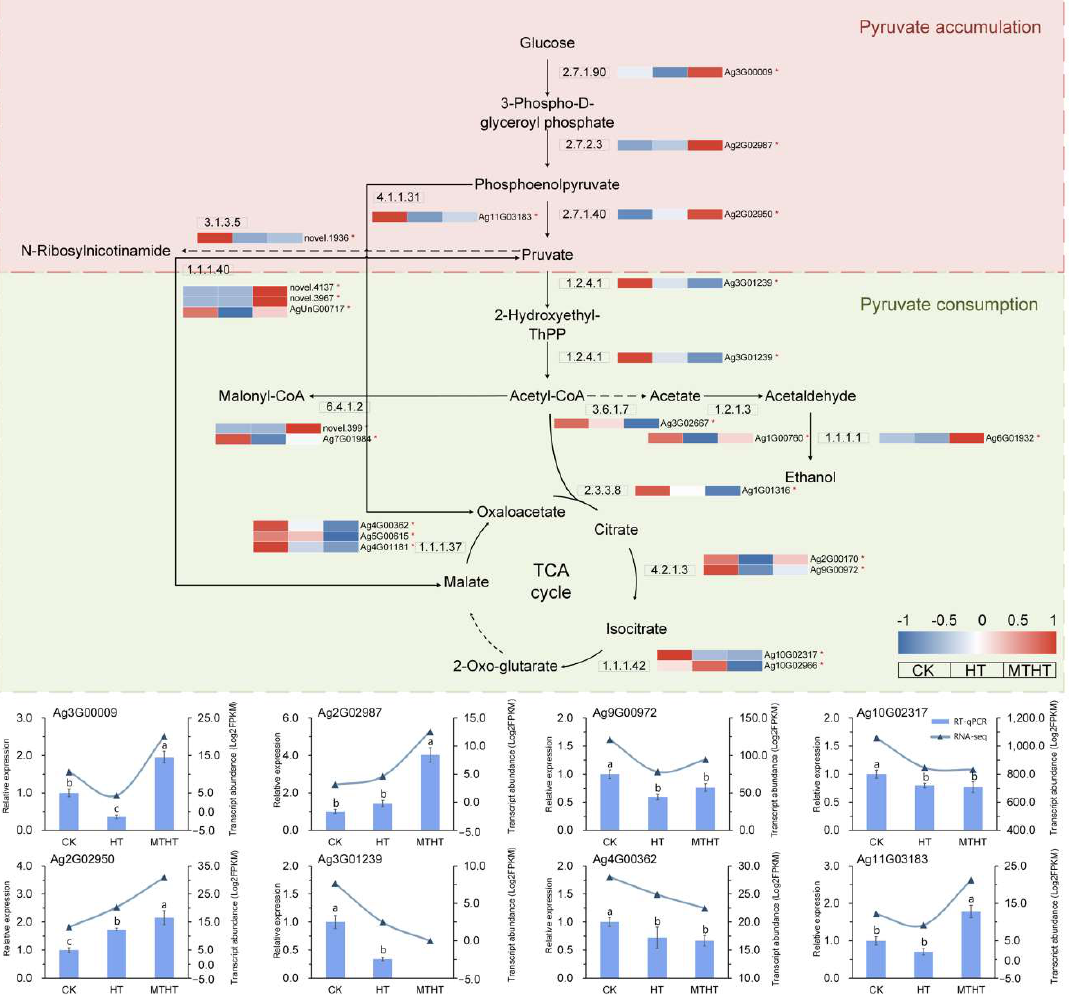
Figure 8. ( A ) Metabolite transformation and gene expression changes in the phenylpropanoid biosynthesis pathway under heat stress. Red (up-tuned) and blue (down-tuned) in the heat map represent gene expression trends. * mean the gene is DEGs. ( B ) RT-qPCR analysis of genes in key pathway under heat treatment. Different letters (a–c) indicate significant differences, while the same letter indicates no significant differences. The column shape represents the relative expression of genes in RT-qPCR, and the curve with triangles represents the RNA-sequencing data.